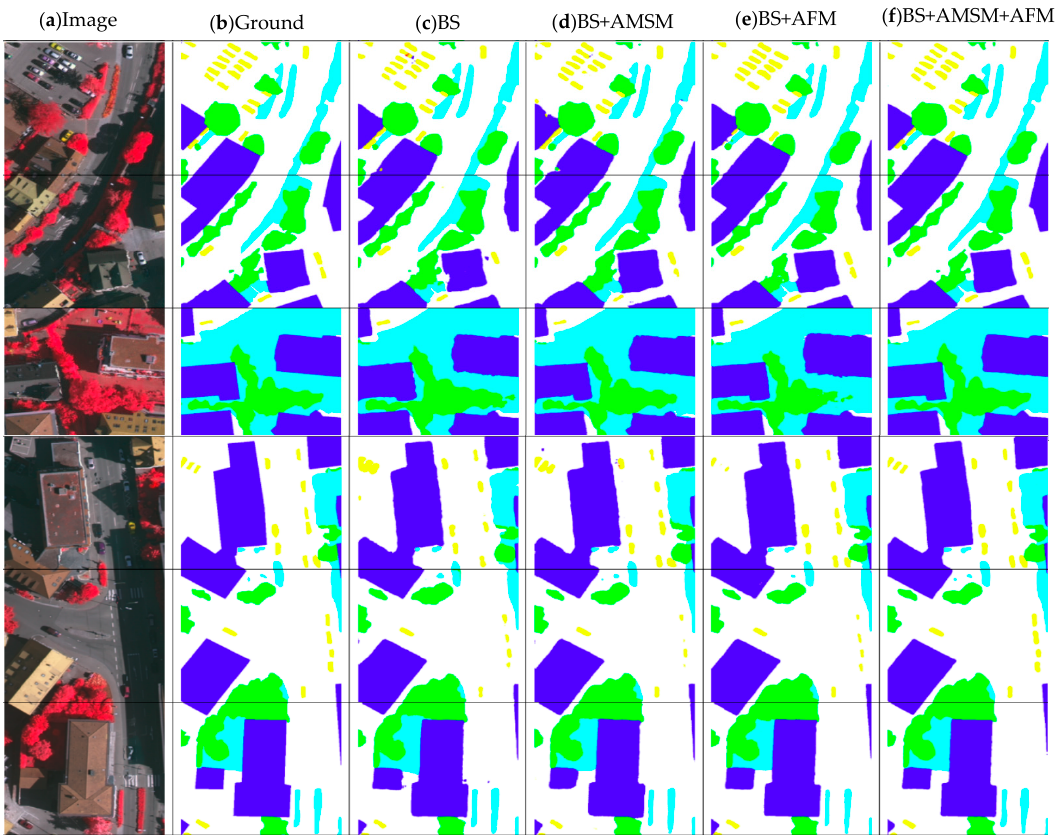
Figure 9. On the ISPRS Vaihingen data set, six test results for the same baseline fusion of different modules. ( a ) Original input image; ( b ) ground truth; ( c ) baseline output image; ( d ) baseline and AMSM output image; ( e ) baseline and AFM output image; ( f ) baseline and fusion of AMSM and AFM. Vaihingen’s label includes six categories: impervious surface (white), building (blue), low vegetation (cyan), tree (green), car (yellow), and chaos/background (red).